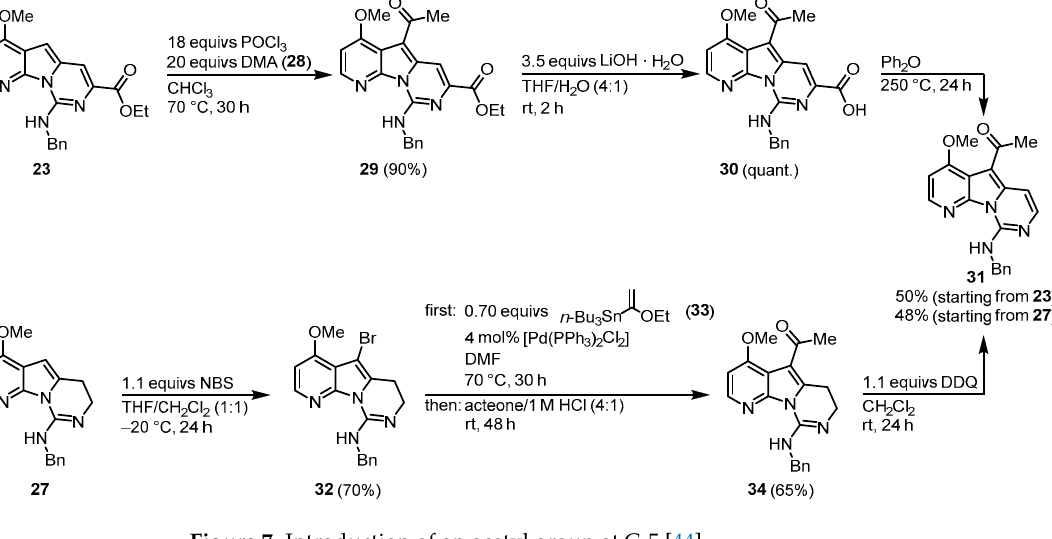
Figure 7. Introduction of an acetyl group at C-5 [44].